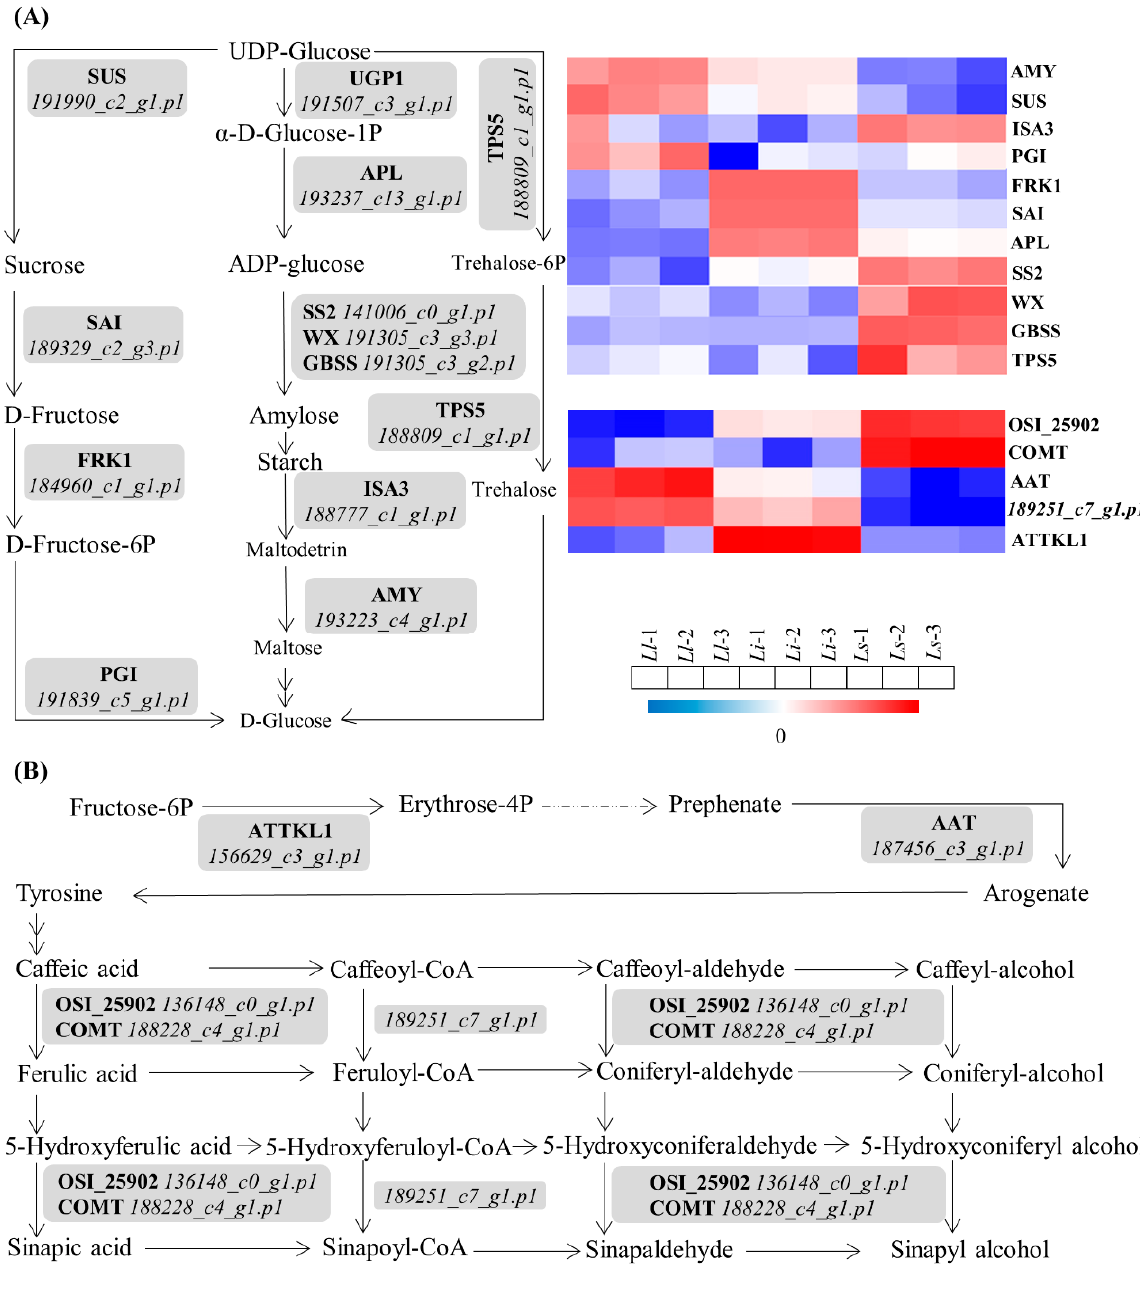
Figure 5. Potenial pathways contribute to the biosynthesis of Amaryllidaceae alkaloids in Lycoris . ( A ) Some proteins were detected to be enriched in starch and sucrose metabolism pathways suggesting a reciprocal regulation between alkaloids and sugar metabolism. ( B ) In secondary metabolic pathways, the up-regulated 187456_c3_g1.p1 and 189251_c7_g1.p1 in Ll participate in the biosynthesis of sinapyl alcohol, resulting in an increase in the alkaloid raw material sinapyl alcohol. Eventually, this leads to a rise in alkaloid content.